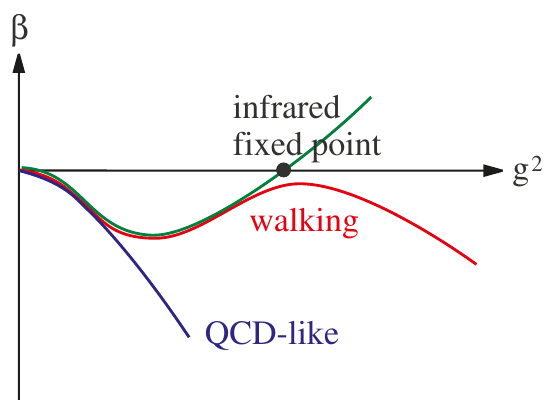
Figure 1 . Sketch of the (cid:12) -functions for QCD-like, conformal, and walking